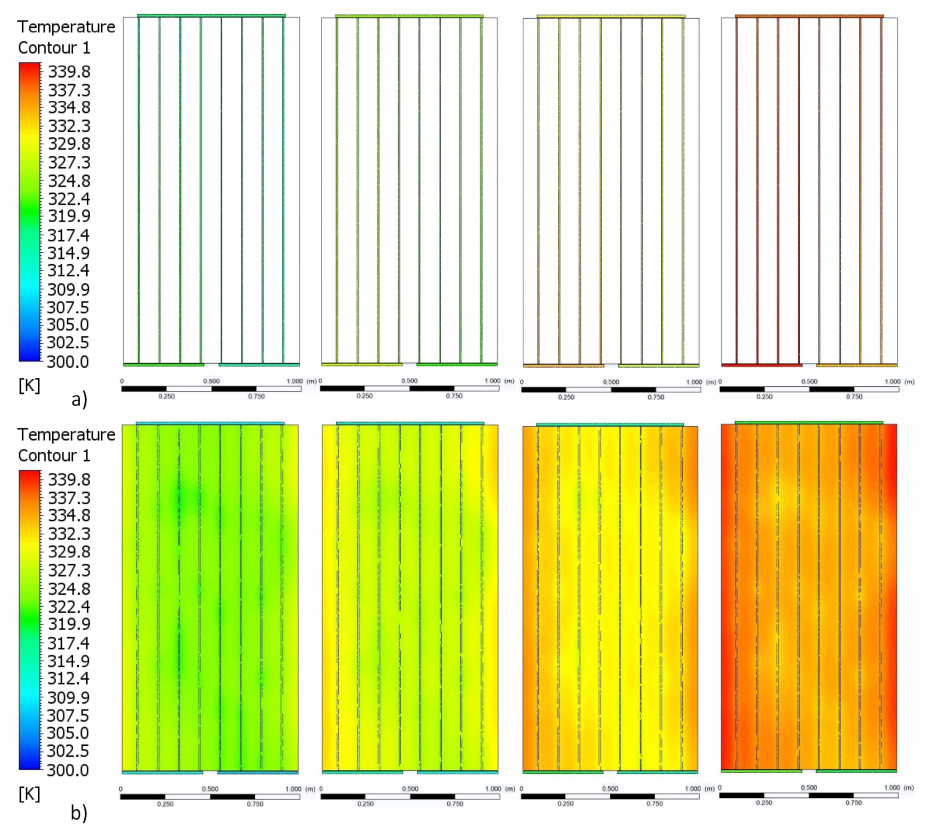
Figure 19. The results of a simulation model of the temperature of solar thermal collectors connected in series, ( a ) heat exchanger pipe; ( b )